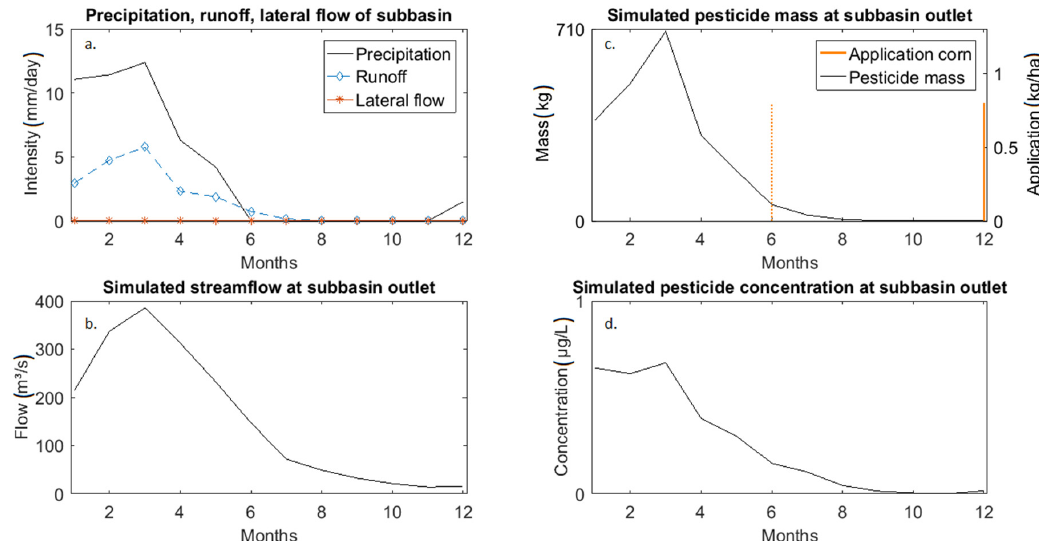
Figure 3. Monthly average precipitation, runoff and lateral flow normalised by the subbasin area ( a ); monthly average streamflow ( b ); total dissolved pendimethalin load transported with streamflow and indication of application rate, where dotted line indicates that the application occurs only at a fraction of the HRUs ( c ); and calculated monthly average pendimethalin concentrations ( d ) at the “Vinces en Vinces” station for pendimethalin application at corn farms.